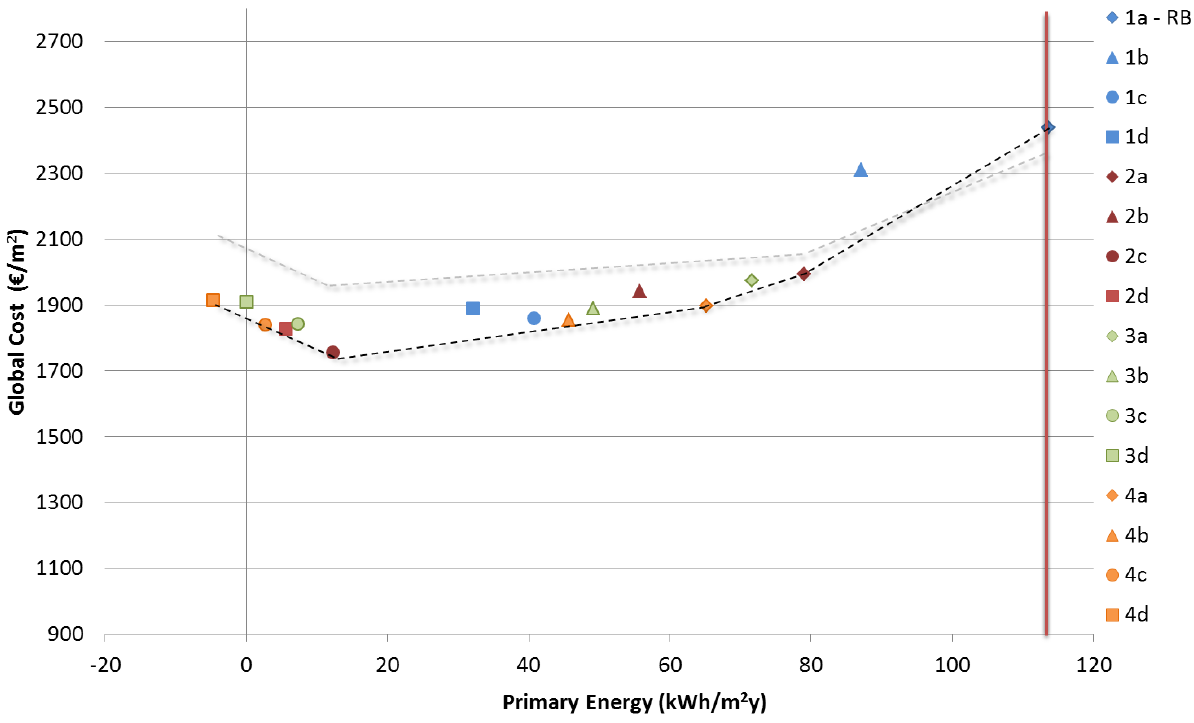
Figure 15. Sensitivity analysis with regard to the variation of the discount rate to